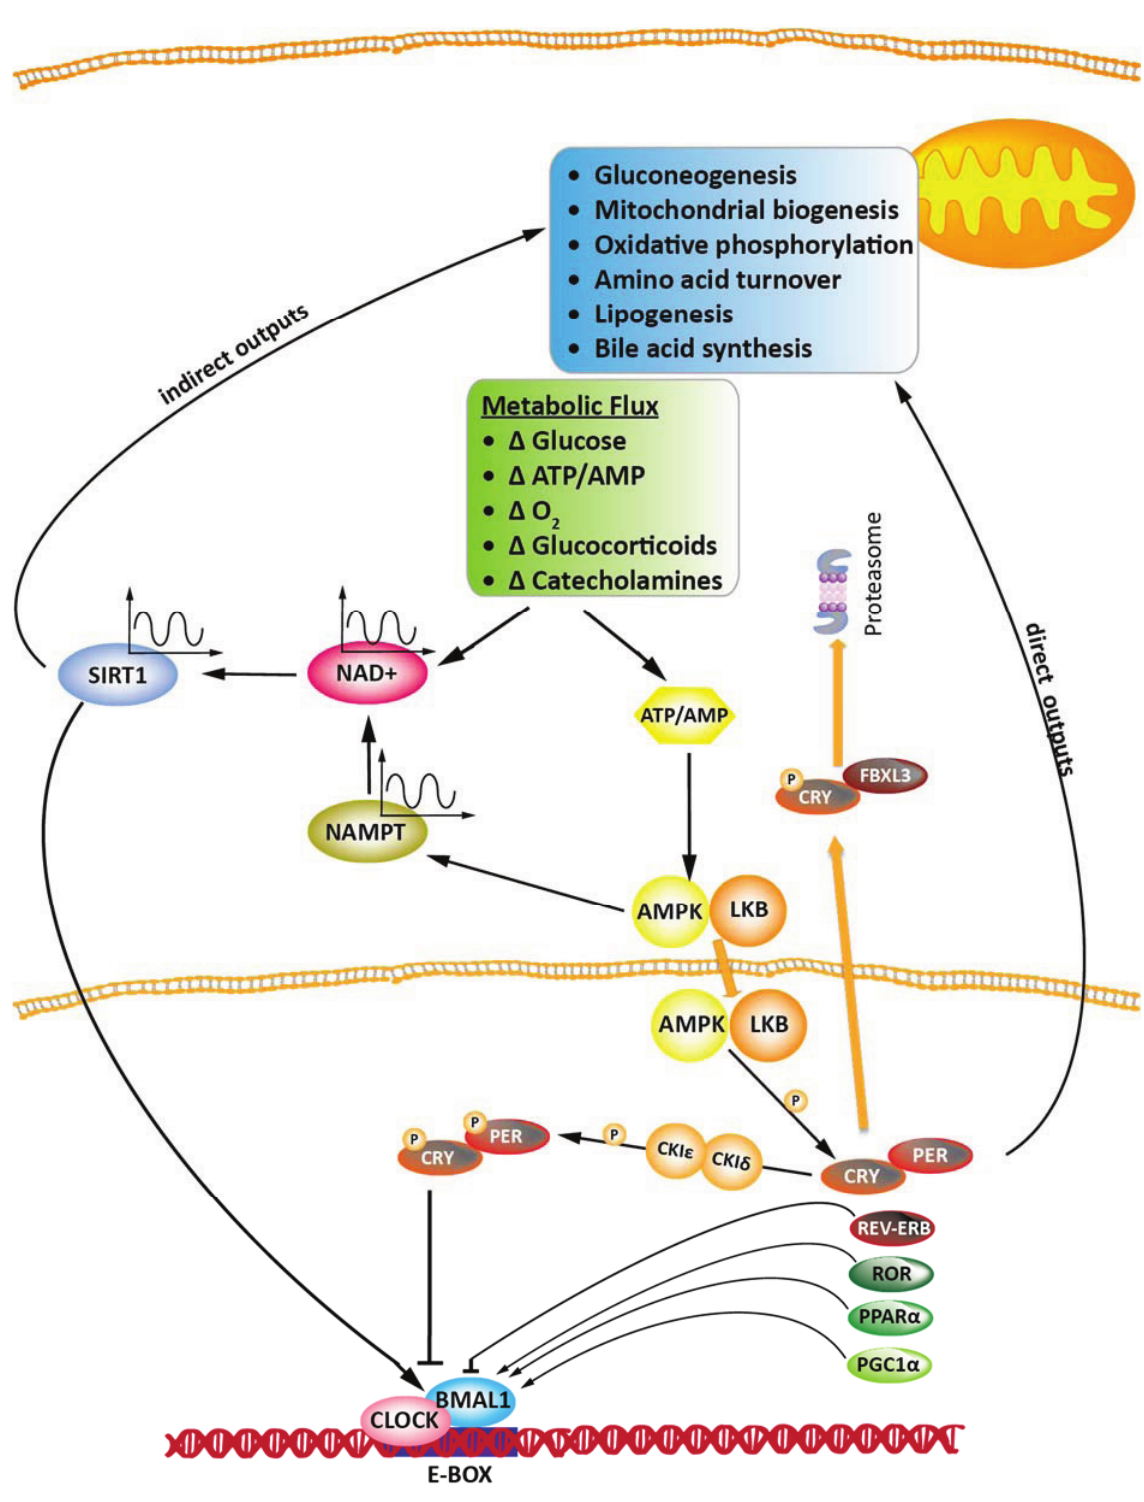
Figure 1. Schematic drawing representing the molecular machine that regulates the circadian clock and its interplay with metabolism. Waves symbolises circadian regulation. NAMPT: nicotinamide phosphoribosyltransferase. See text for